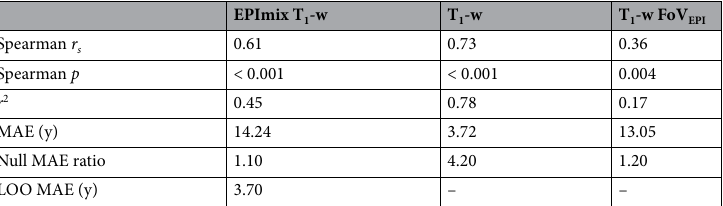
Table 1. Correlation and Median Absolute Error between chronological age and predicted brain-age. The Null MAE ratio compares each MAE estimate to the MAE from the worst possible brain-age model (null MAE = 15.6 years, assuming identical prediction of the mean age of the brainageR training sample for all participants). The leave-one-out (LOO) cross-validation MAE was derived using regression of T 1 -w-predicted brain-age onto EPImix-predicted brain-age. For details, see Methods section Statistical analysis .